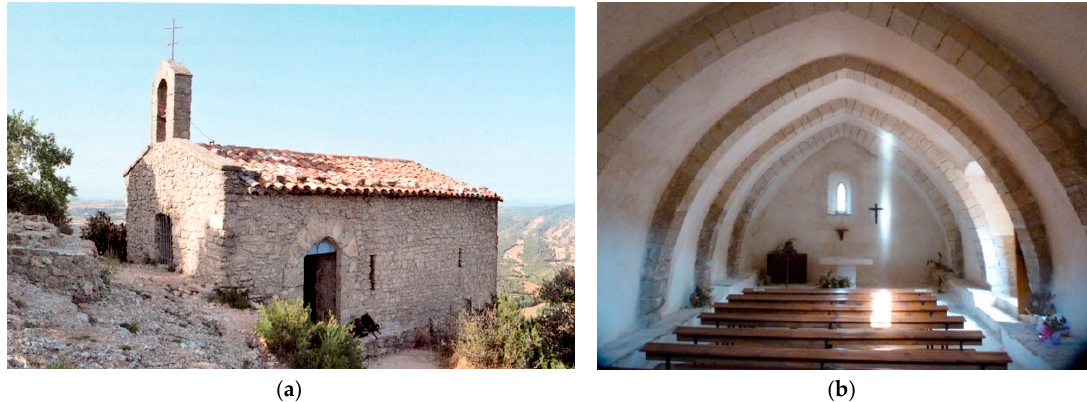
Figure 32. Castles chapels in the province of Tarragona (Catalonia, Spain). ( a ) Church of Sant Miquel